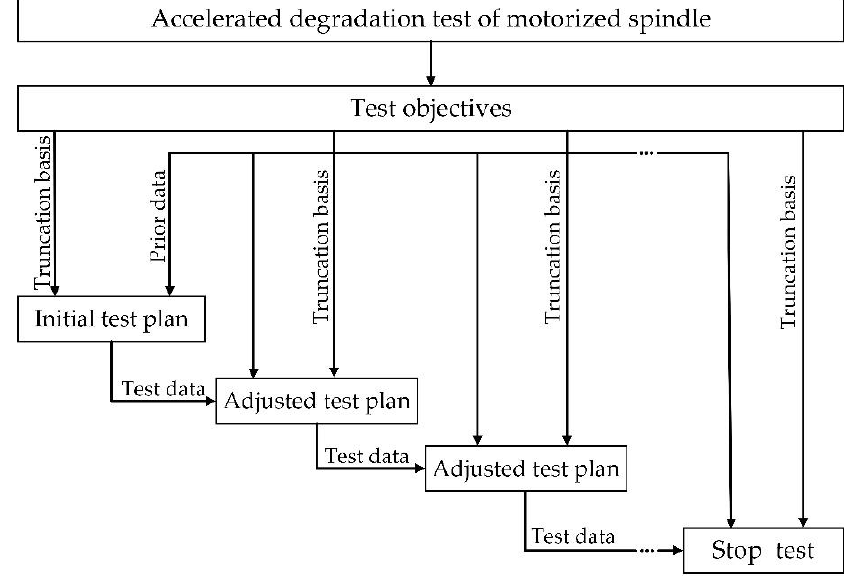
Figure 3. General flow of sequential design for ADT plan of motorized spindle